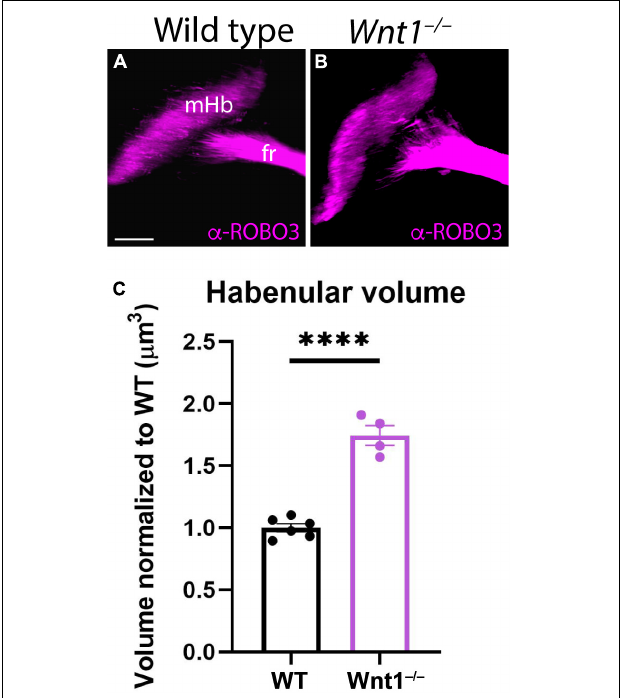
FIGURE 2 | Medial habenular volumes analysis in Wnt1 − / − . Lateral views of E18.5 wt (A) and Wnt1 − / − (B) brains analyzing ROBO3 distribution by iDISCO. We can observe the mHB and the initial fr portion. (C) Significance among wt ( n = 6) and Wnt1 − / − mHb volumes ( n = 4) was analyzed by an unpaired t -test. Significant differences were found ( ∗∗∗∗ < 0.0001), being the mutant mHb volume larger than the wt. fr, fasciculus retroflexus; mHb, medial habenula. Scale bar: 200 µ